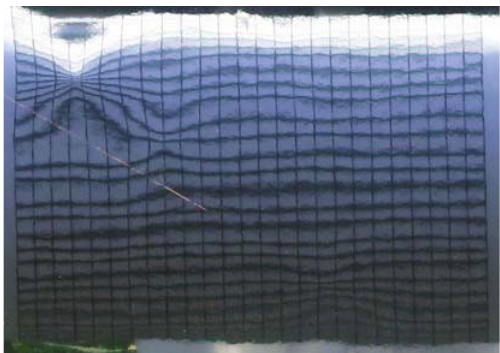
Figure 8: Elaboration of Figure 7 aimed to highlight the spatial in- formation (two-level binary image) of the horizontal lines. In the figure have been superimposed the horizontal reference lines.